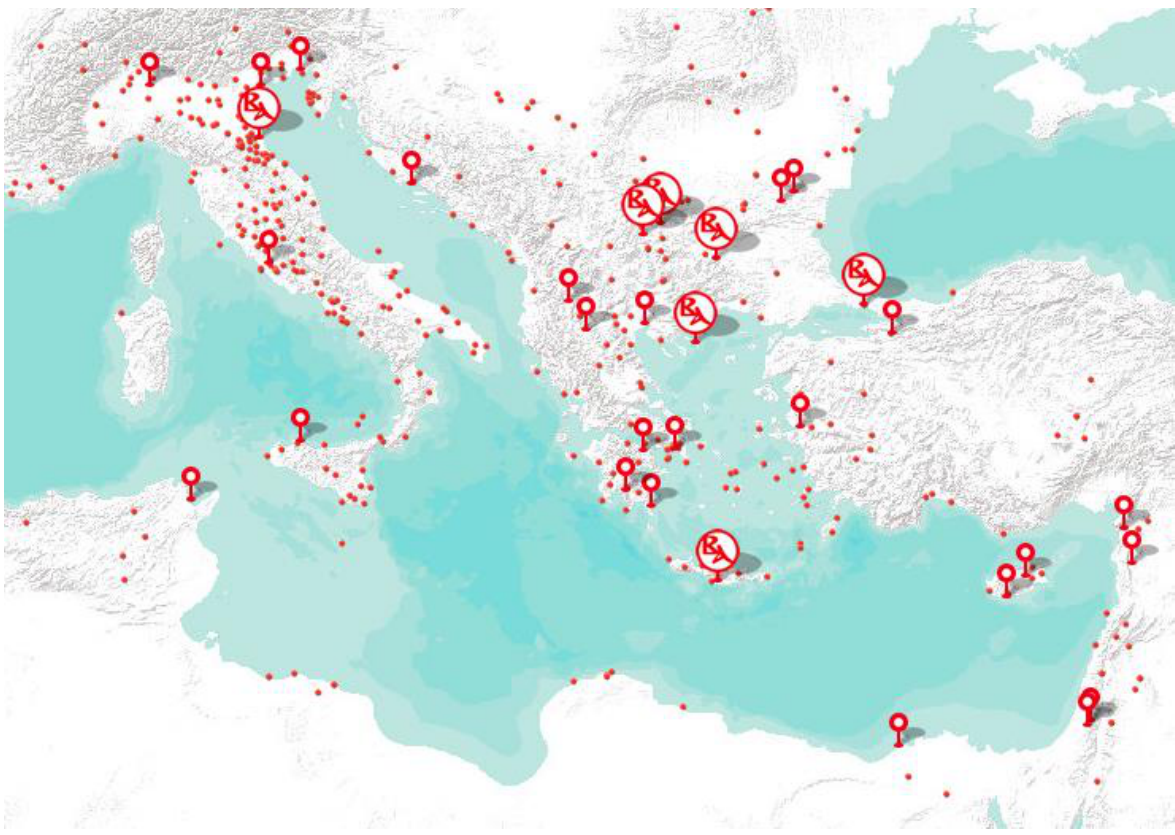
Figure 4. Section of the map of locations of the BYZART project’s items.